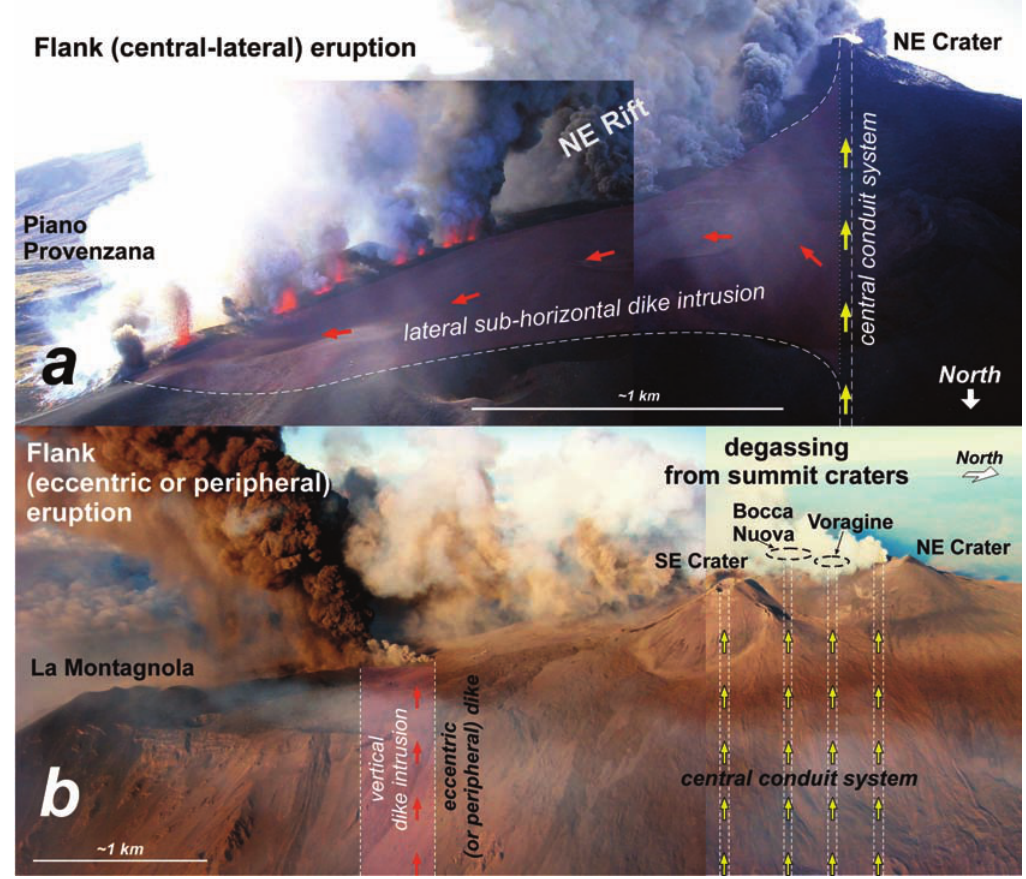
Figure 3. Conceptual model of the two types of flank eruptions at Etna, central-lateral (a) versus eccentric (or peripheral) (b), as illustrated by the two phases of the 2002-2003 eruption. (a) Lateral transfer of magma from the central conduit (the NE Crater) into the NE Rift leads to a typical central-lateral eruption, with numerous vents aligned along a downslope-propagating eruptive fissure system of more than 5 km long (October 27 – November 5, 2002). (b) Eruptive activity on the upper S flank is fed through a new, eccentric conduit, and restricted to a relatively short fissure with fewer vents. The activity here is characterized by much more enhanced explosivity compared to the central-lateral activity on the NE Rift (October 28, 2002 – January 28, 2003). Both central-lateral and eccentric activities occurred simultaneously during the 2001 and 2002-2003